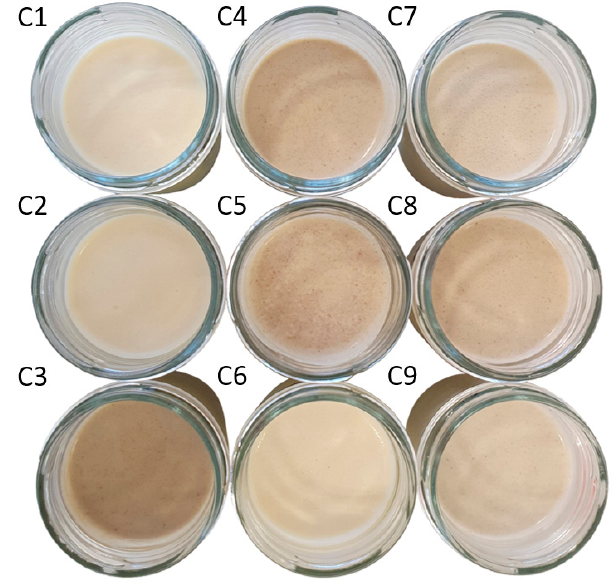
Figure 2. Images of the nine spreadable cheese analogues used in the experiments. The samples, labelled from C1 to C9, contain different ratios of milk protein concentrate, faba bean protein concen- trate and insect flour (MPC/FBP/IF): C1 (100/0/0), C2 (50/50/0), C3 (0/50/50), C4 (50/0/50), C5 (75/0/25), C6 (75/25/0), C7 (25/50/25), C8 (25/25/50) and C9 (50/25/25).